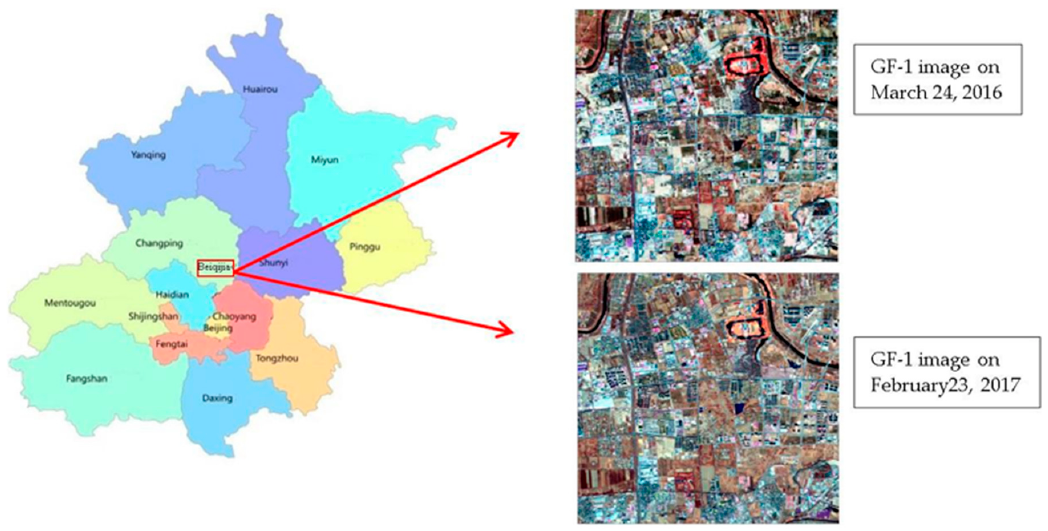
Figure 1. Map and GF-1 satellite images of the study